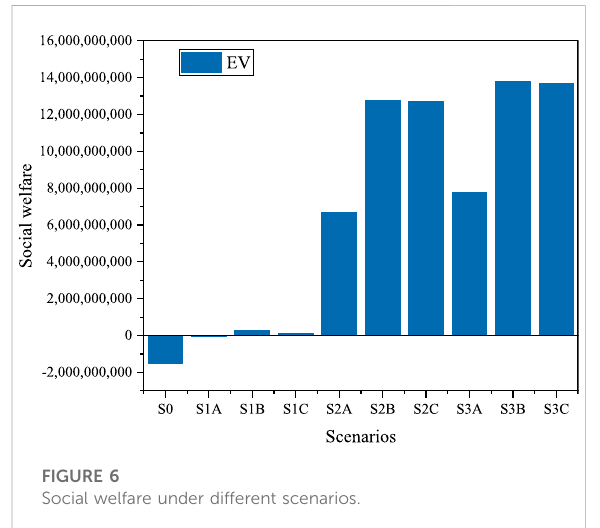
FIGURE 7 Amount of government transfers to residents (ten thousand